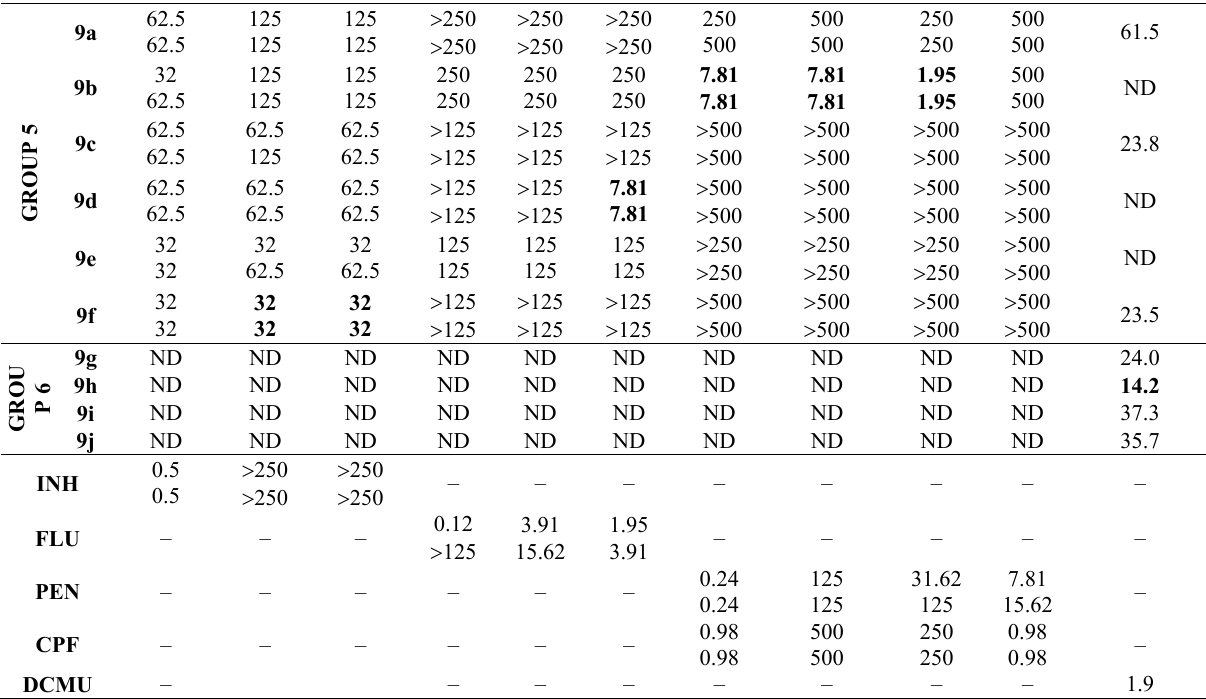
The MIC determinations were performed according to the CLSI reference protocol: a mycobacteria (IC value), b M27-A2 for yeasts (IC 90